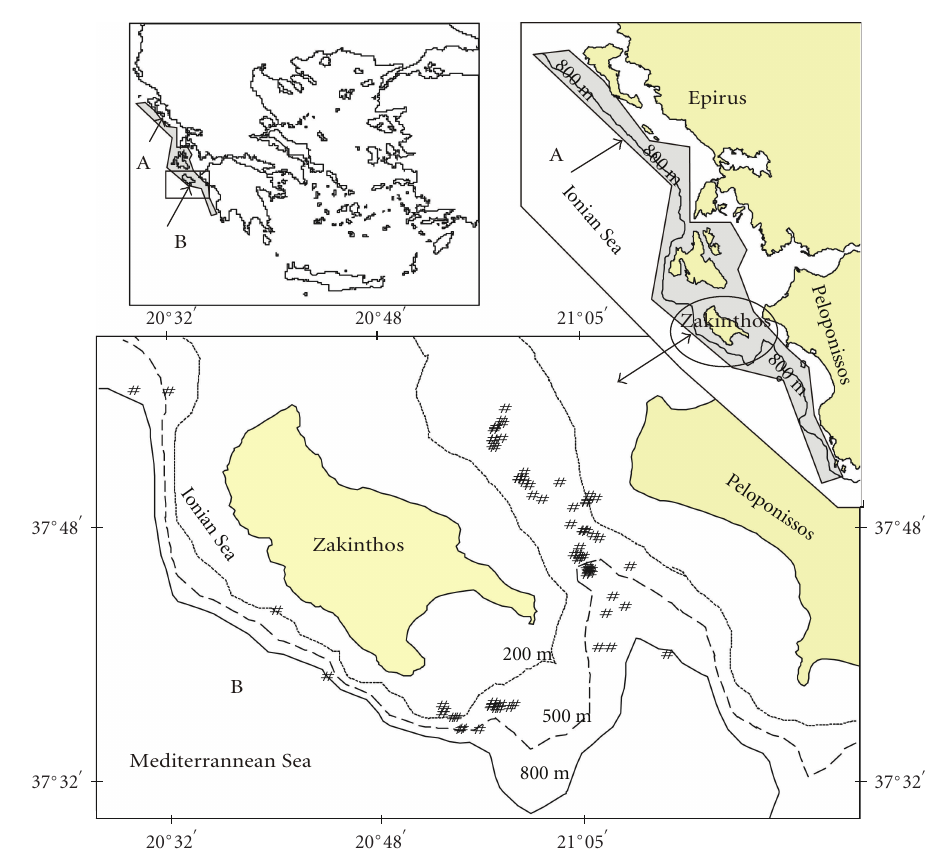
Figure 1: Map of the research area (A = deep waters of the North Ionian Sea, B = sampling area with sampling stations (#)).